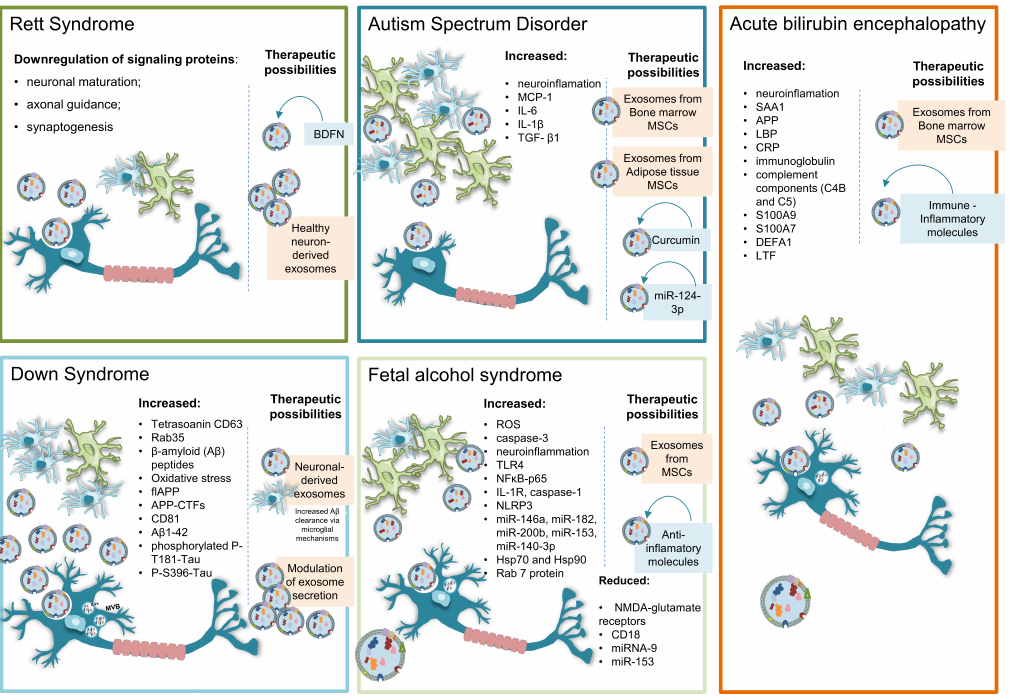
Figure 2. Schematic illustration summarizing the main changes observed in the cargo of EVs in the neurodevelopmental disorders that are discussed in this review. Therapeutic possibilities using or targeting exosomes are also